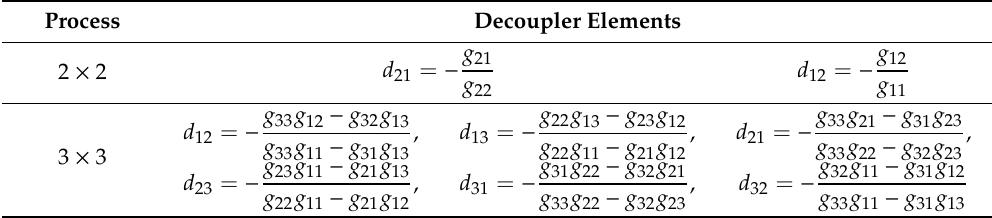
Table 1. The matrix elements of the simplified decoupler for 2 × 2 and 3 × 3 processes.